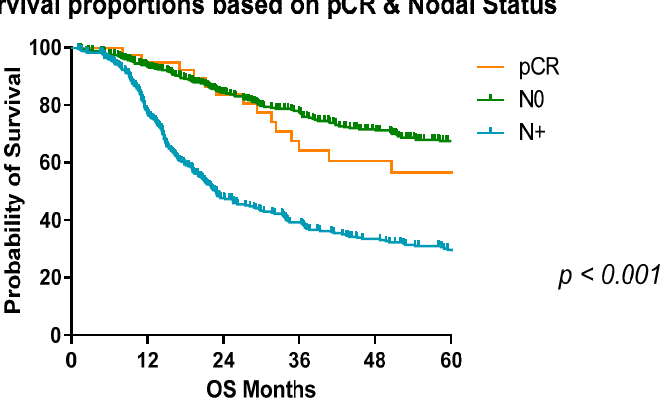
Figure 4. Survival proportions of OAC patients based on nodal status and pathologic complete response. pCR refers to complete pathological response on histological analysis, N0—node negative, N+—node positive. Significantly reduced overall survival with nodal disease. Median survival: pCR, not reached; N0, 124.6 months; N+, 22.9 months. Table 5. Overall survival of OAC patients based on nodal status and treatment received (chemoradiotherapy/chemother- apy).